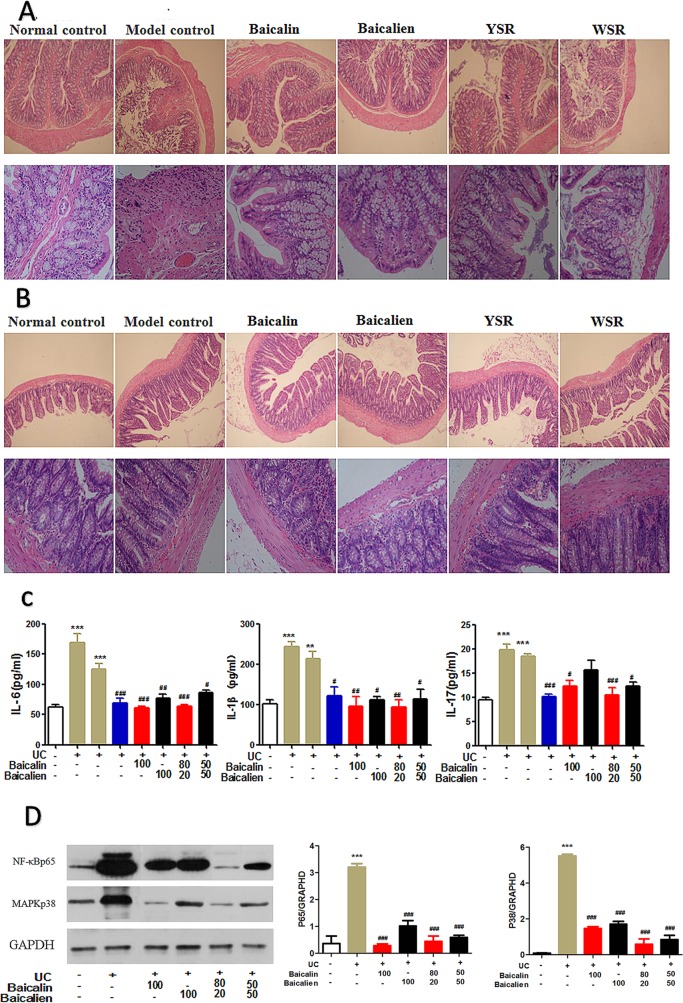
Protection effects of baicalin and baicalein in UC. (A), Colon pathology; (B), Ileum pathology; (C), Inflammatory cytokines; (D), NF-κB and MAPK protein. The data are presented as the mean ± S.D. (n = 7); **P < 0.01, ***P < 0.001 compared to the NC group; #P < 0.05, ##P < 0.01, ###P < 0.001 compared to the self-healing group. The left second column is UC model group, the left third column is self-healing group, the left fourth column is SASP group.